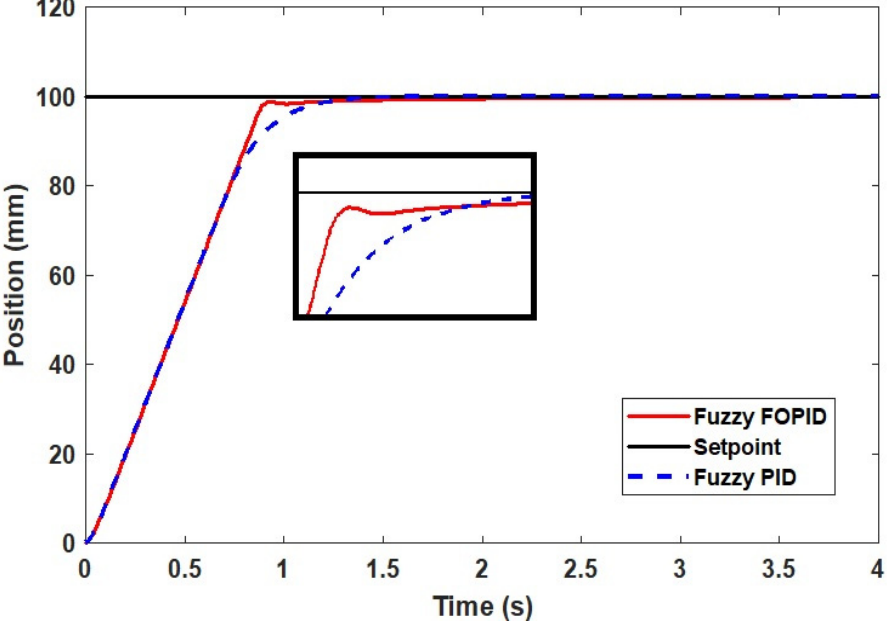
Figure 21. Dynamic response of the system with the fuzzy FOPID and fuzzy PID controllers under parametric uncertainties, case 1.